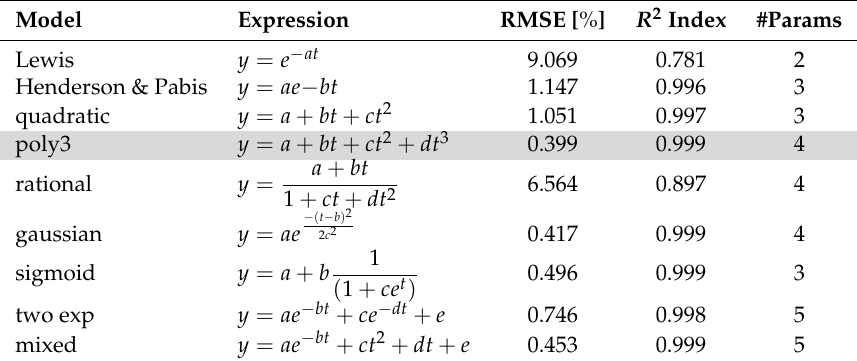
Table 1. Drying models fitted to experimental data; t = time and y = moisture.